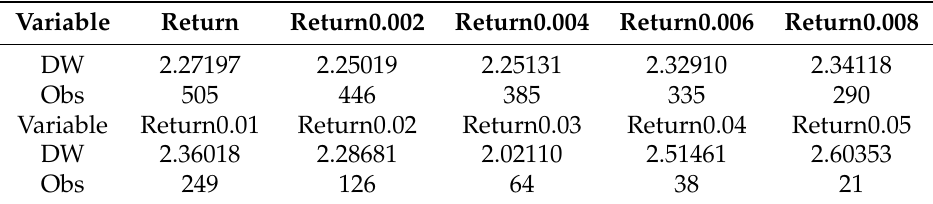
Table 3. Durbin–Watson Test on 2008